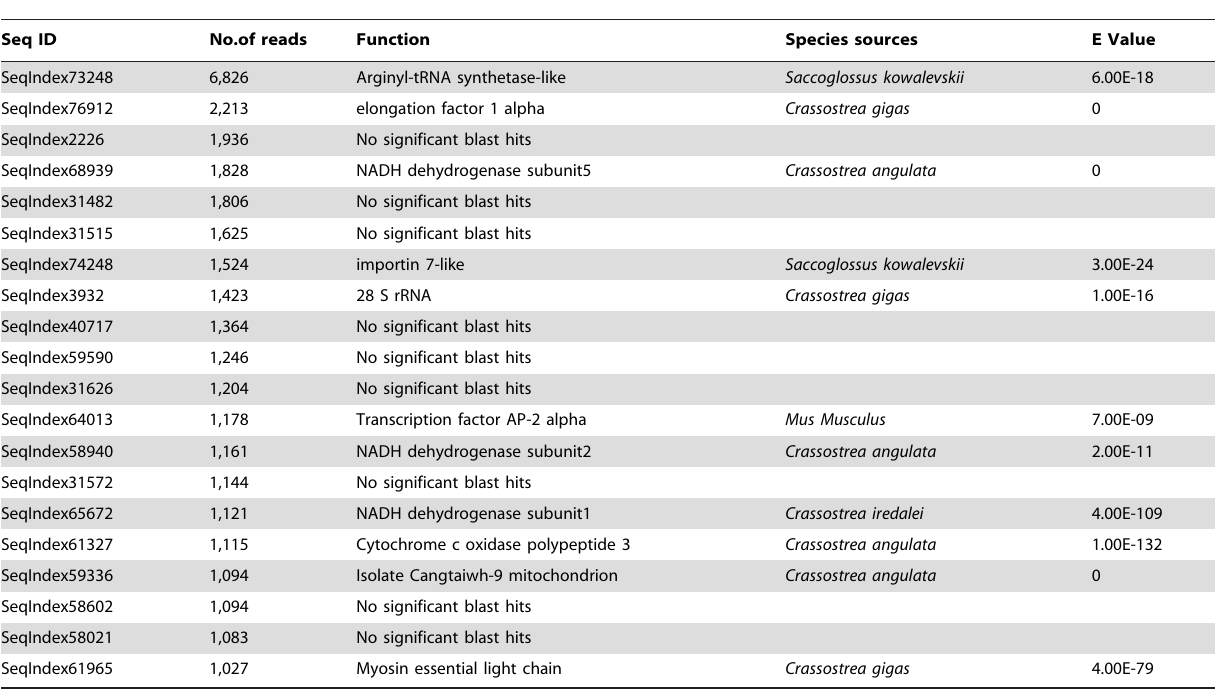
Table 2. Most commonly expressed sequences with associated Blast matches of C. angulata.